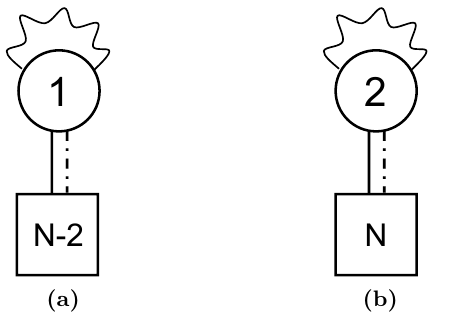
Figure 13. (a) The quiver diagram describing the monopole screening contribution to the v = e i − e j sector in h T monopole screening contribution to the v = 0 sector in h T